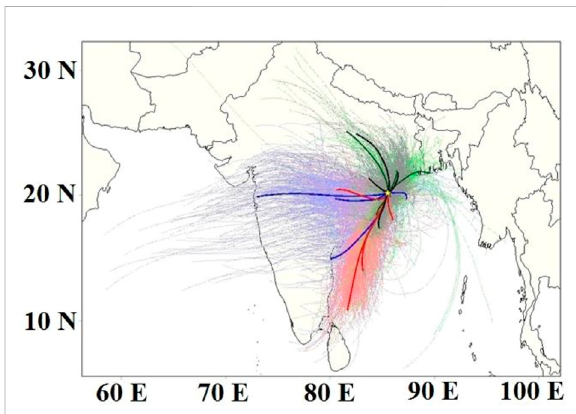
FIGURE 4 The back trajectory and cluster analysis at the sampling site (marked with a yellow star) during post-monsoon (green color), winter (black color), pre-monsoon (red color), and monsoon (blue color). Thin lines represent the back trajectories, while thick lines represent clusters for respective seasons.